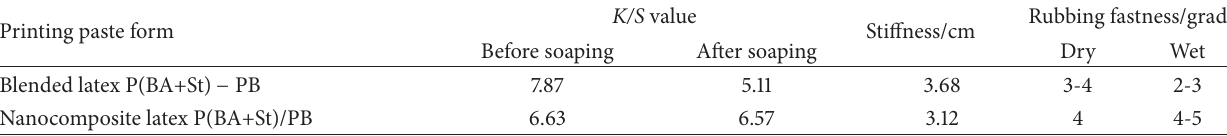
K/S value Rubbing fastness/grade Stiffness/cm Before soaping After soaping Dry Wet